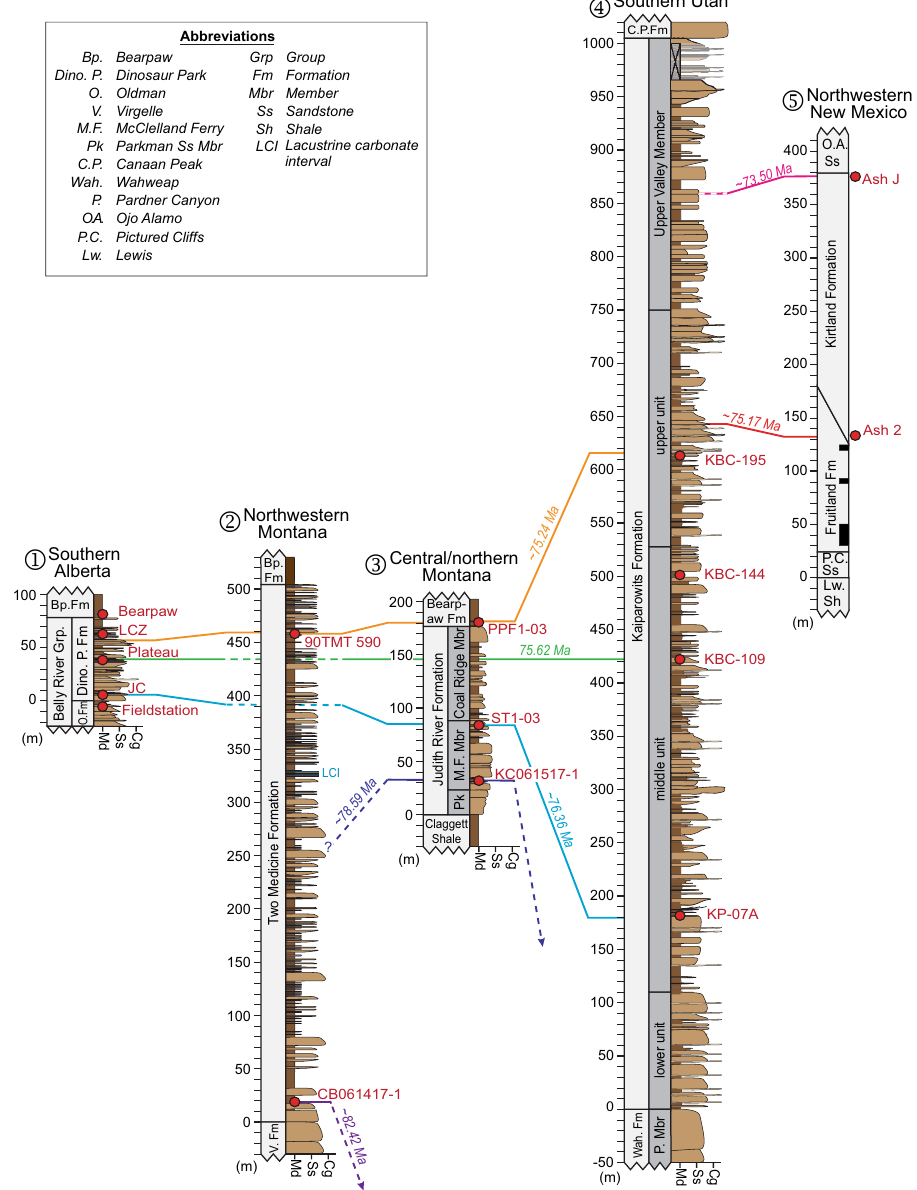
Figure 6. Temporal correlations among five principal Campanian fossil-bearing formations of the Western Interior Basin, based on the age models of this study. Stratigraphic columns are drawn to the same scale. Black is coal bed. Red dots mark ash beds with U–Pb ages connected by color-coded temporal correlation lines; dashed lines signify age projection in the absence of a quantitative age-stratigraphic model. Lithostratigraphy after: (1) Eberth and Hamblin 36 , (2) Rogers 50 , (3) Rogers et al. 83 , (4) Roberts et al. 105 , (5) Fassett and Heizler 114 , Sullivan and Lucas 144